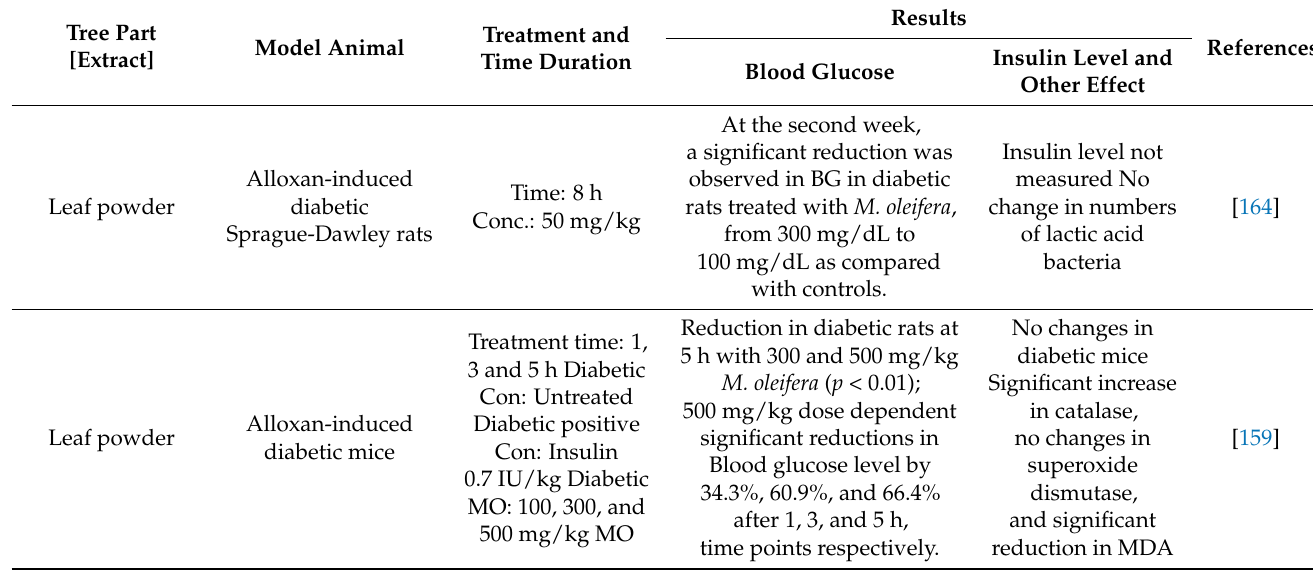
Table 6. Antidiabetic activity of M. oleifera plant